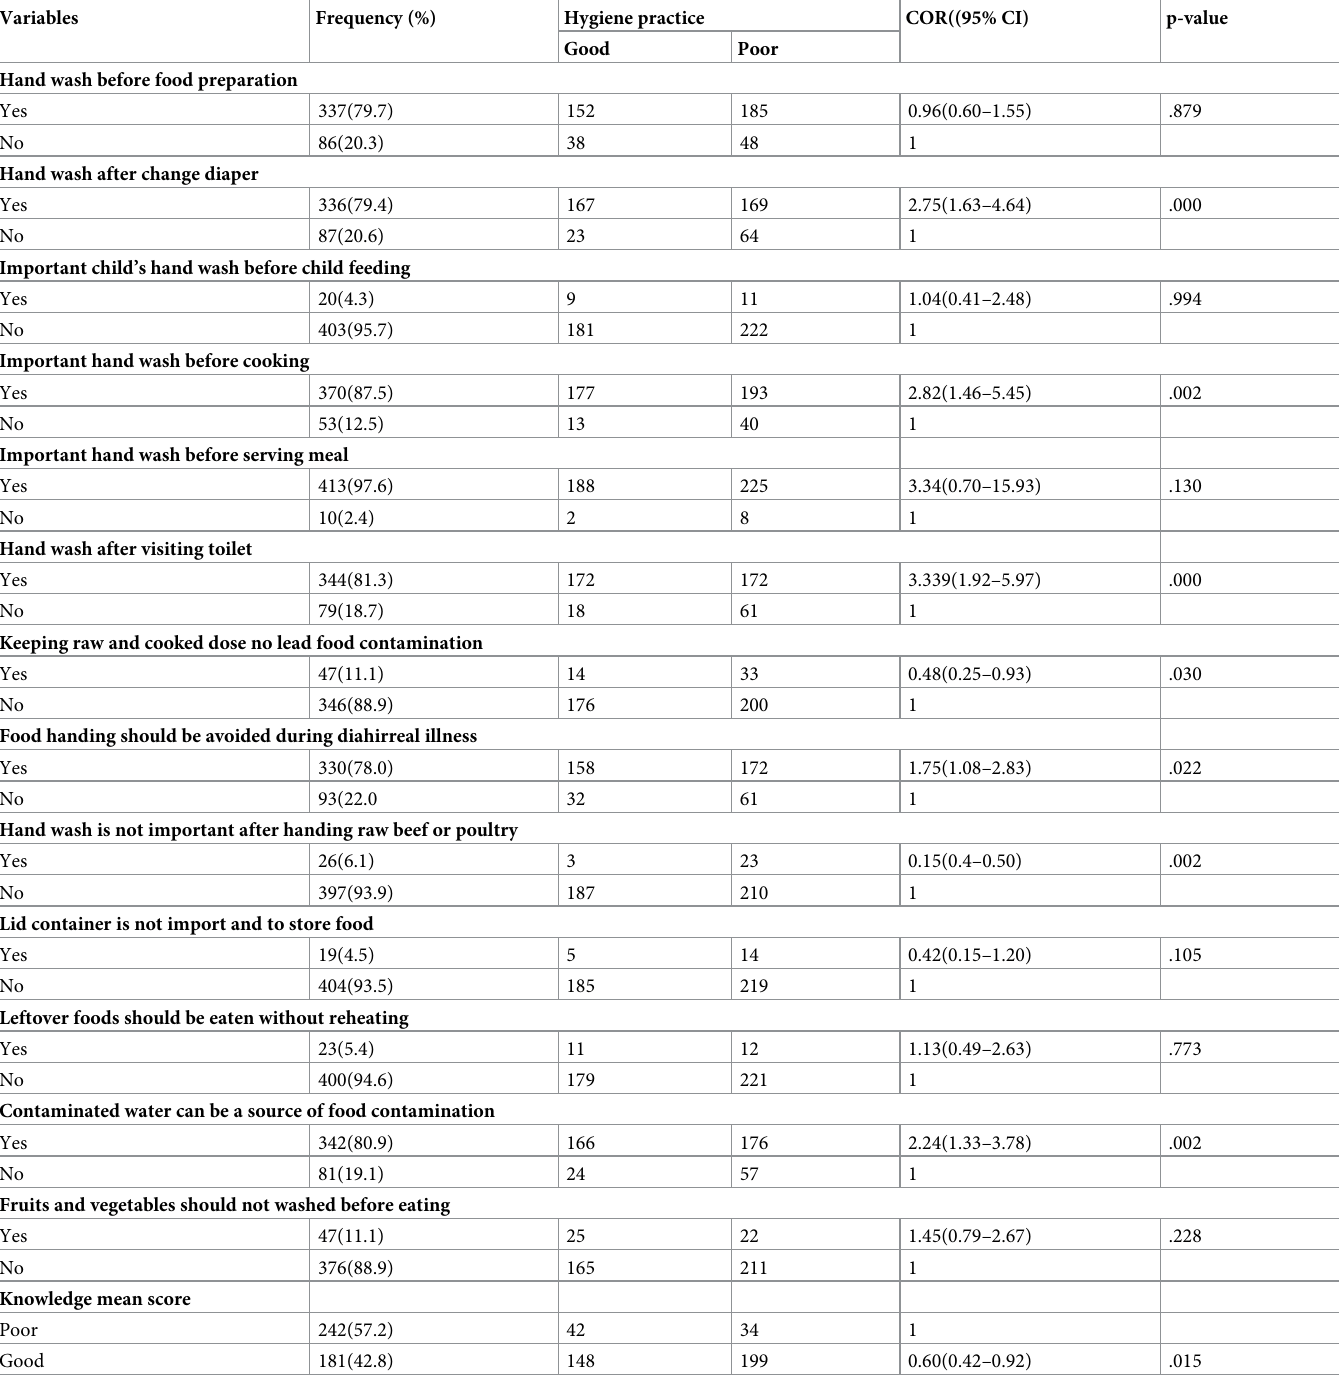
Table 4. Bivariate analysis of the association household knowledge with hygiene practice during complementary food preparation with 6–24 months aged of chil- dren in Debark town northwest Ethiopia, 2021(n =